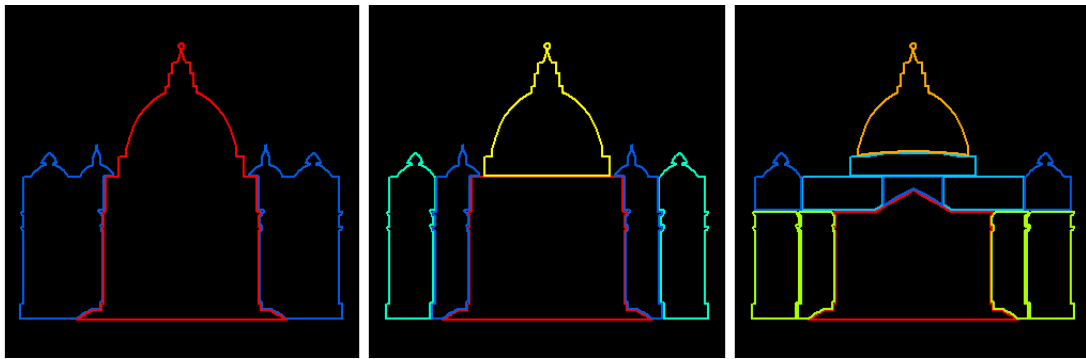
Figure 1. Facade of the St Peter’s basilica with scaling patterns across multiple scales. Large areas are denoted by warm colors, while smaller and more numerous areas are denoted by colder colors [23].